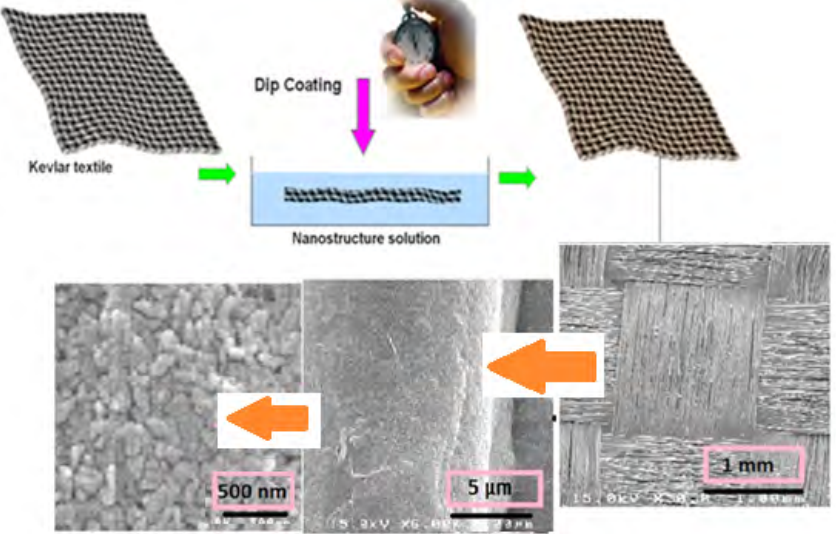
Fig. 1. The preparation process of hydrophobic functionalized Kevlar